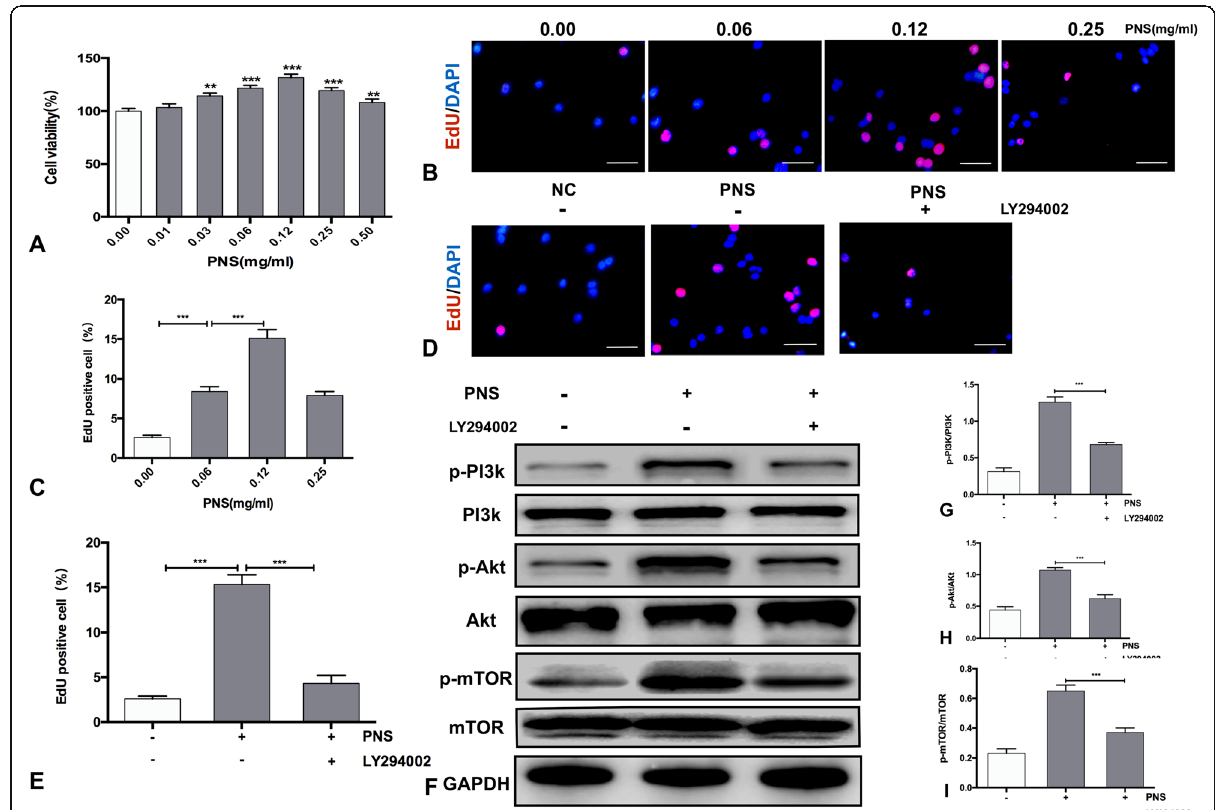
Fig. 1 PNS promoted primary mouse hepatocyte proliferation via the PI3K/AKT/mTOR signaling pathway. The primary mouse hepatocytes were treated with a range of concentrations of PNS for 24 h. Cells were preincubated with or without 10 μ M LY294002 for 1 h and were then treated with 0.12 mg/ml PNS for 24 h. ( a ) The cell viability was determined by CCK-8 Kits. ( b ) Primary mouse hepatocytes were pretreated with 0.00, 0.06, 0.12 and 0.25 mg/ml PNS for 24 h and EdU (pink) staining was measured (magnification: × 400, Scale bars represent 50 μ m). ( c ) Quantification of EdU-positive cells. ( d ) Representative immunofluorescent images of primary mouse hepatocyte proliferation measured by EdU staining (magnification: × 400, Scale bars represent 50 μ m). ( e ) Quantification of EdU-positive cells. ( f ) Total and phosphorylated protein levels of PI3K, AKT and mTOR in primary mouse hepatocytes. Values represent the mean ± SEM of 3 independent experiments. ( g )( h )( i ) Bar graph shows the quantification of total and phosphorylated protein levels of PI3K, AKT and mTOR. Values represent the mean ± SD of at least three independent experiments. ** P < 0.01, *** P <